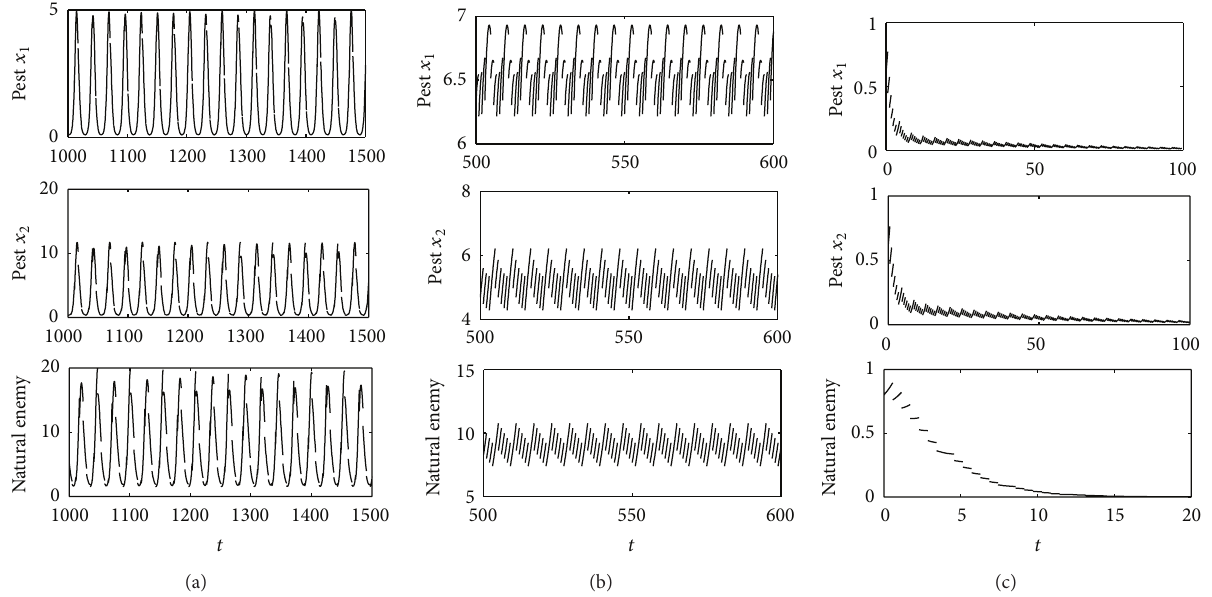
= 0.95 , 𝛿 = 0.85 , 𝛿 = 0.85 , 𝜃 = 0 , 𝑇 = 6 , and 𝑞 = 6 , (c) 𝛿 1 2 3